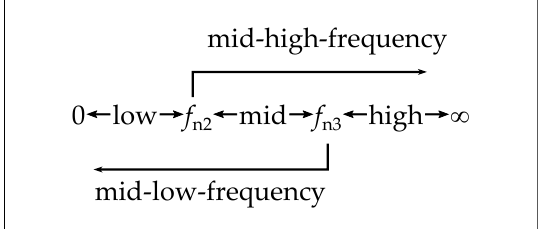
Figure 5. Schematic diagram of frequency bands division for AHM.